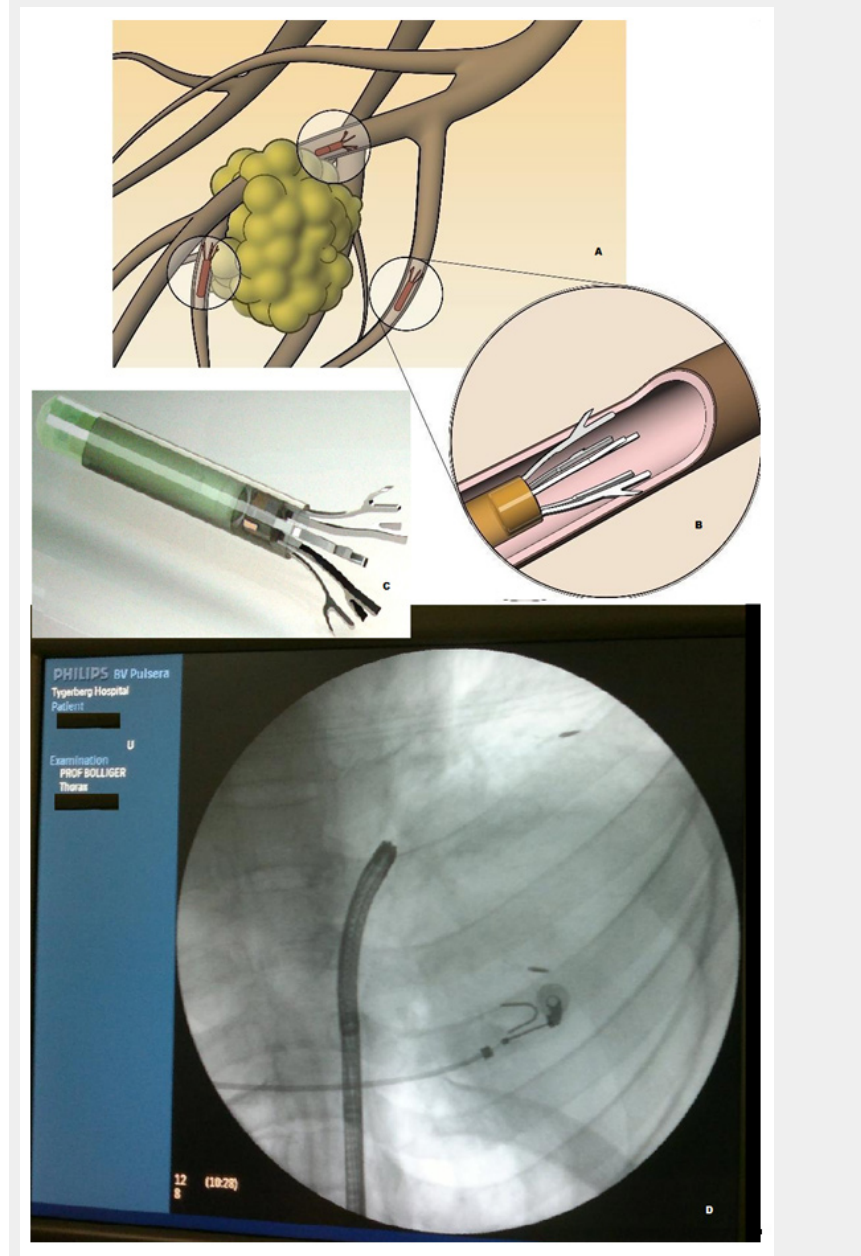
A- Schematic representation of Anchored Beacon® Transponders in situ around the tumor; note: each transponder is deployed in a separate airway; B- Magnified view of the distal end of a transponder showing anchorage in a bronchus; C- The actual Anchored Transponder, approximately the size of a grain of rice; D- Fluoroscopic view of the anchored transponders in situ. In a large right sided lung cancer two out of three transponders have been deployed, one just distal to the ECG electrode, the second one at the distal tumour adjacent to normally aerated